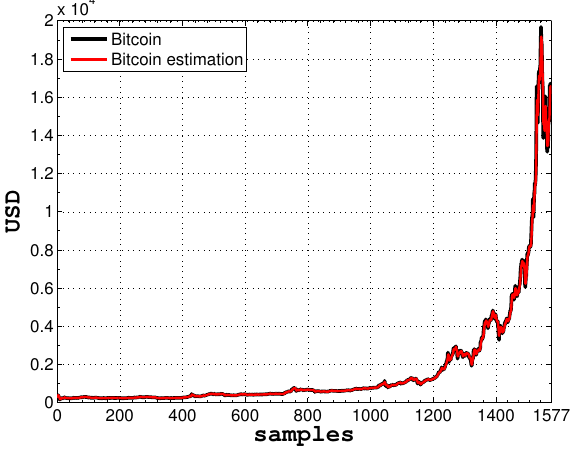
Figure 7. Example 4. Bitcoin fitting.